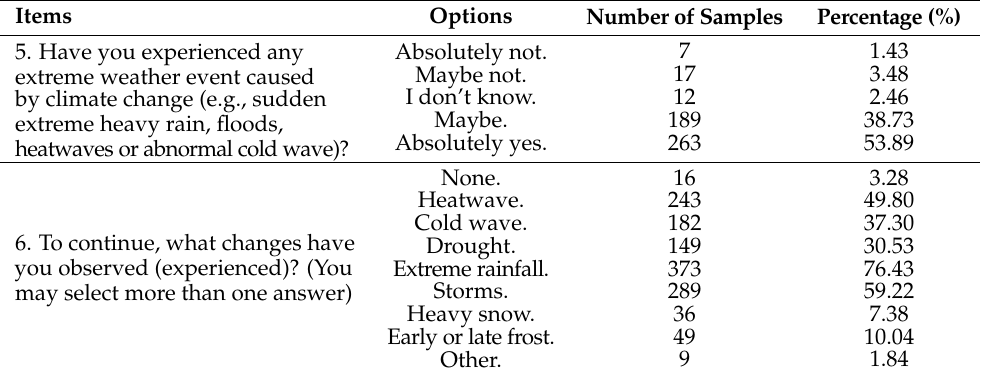
Table 5. Respondents’ experience of extreme weather events caused by climate change.